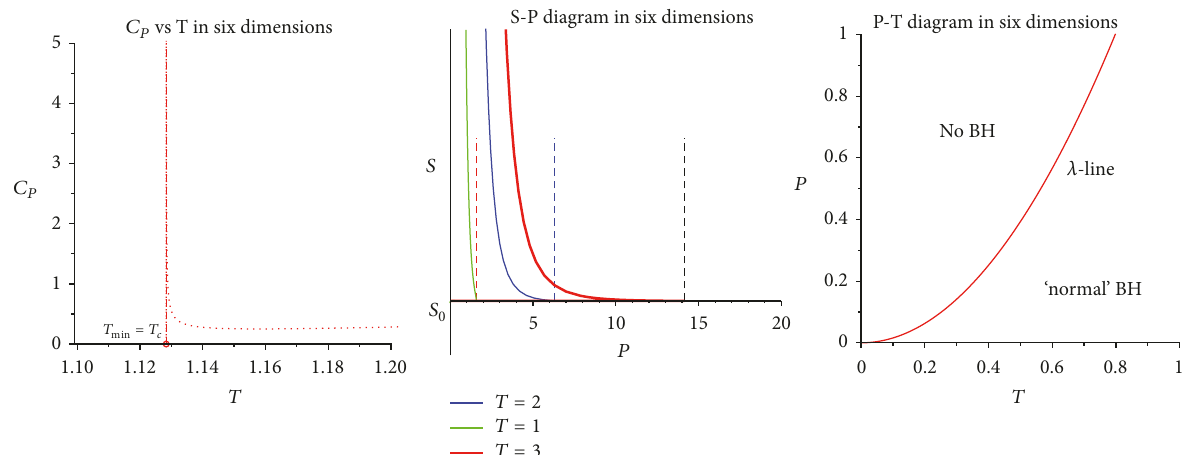
Figure 5: Curves of 𝐶 𝑃 − 𝑇 and 𝑆 − 𝑃 and 𝑃 − 𝑇 parameter space of black holes with 𝜖 = 𝜖 𝑐 in six dimensions. The dashed lines highlight the minimal temperature, which could be treated as a physical temperature constraint and cancel the “superfluid” black hole phase. Therefore there is no 𝜆 phase transition in six dimensions even when the specific heat